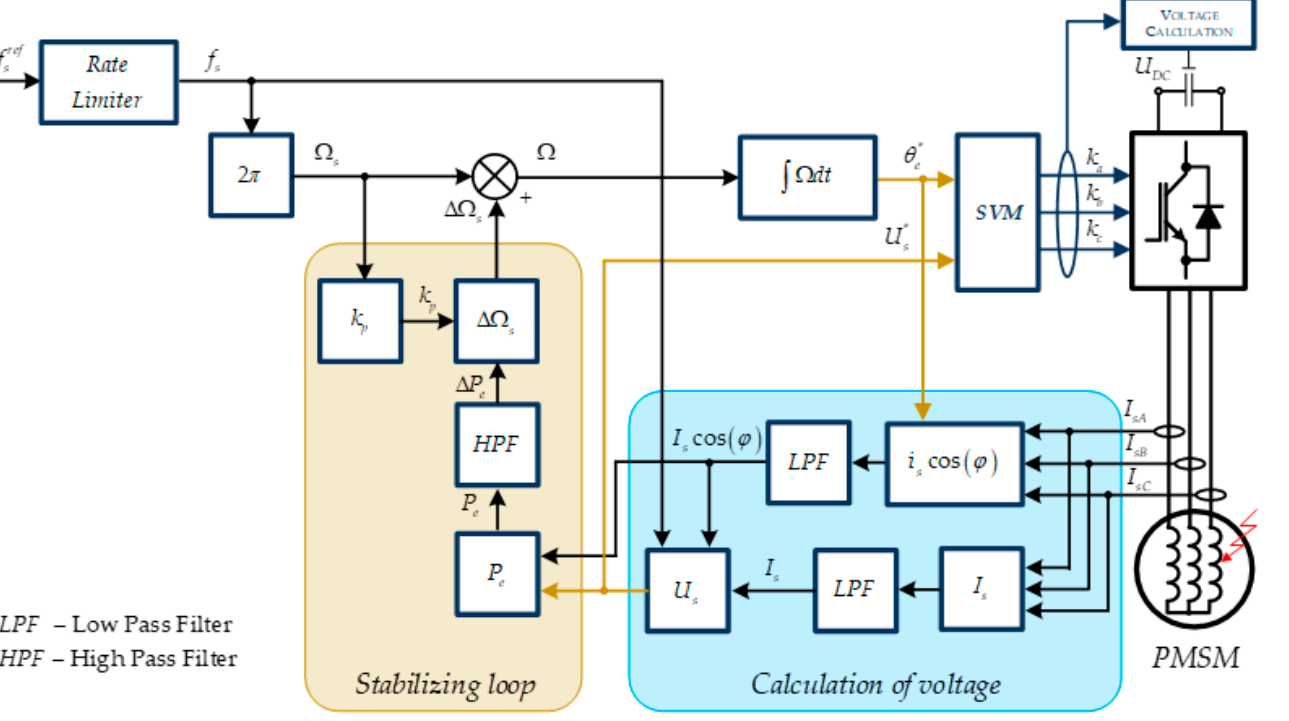
Figure 5. Stator voltage calculation with R s —voltage drop and load torque compensation.